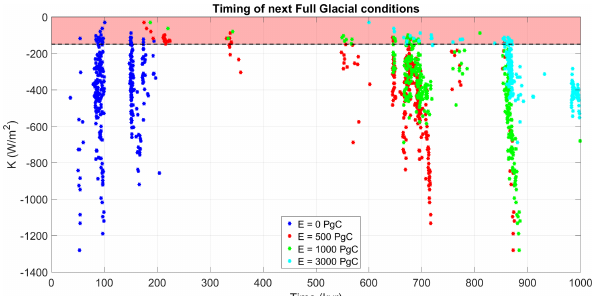
Figure 3. Dependence of the timing of the next full glacial con- ditions ( v = 0 . 5) on the parameter K for all solutions in Paleo- valid and under the different emission scenarios considered. The red shaded area indicates the solutions in the Accepted